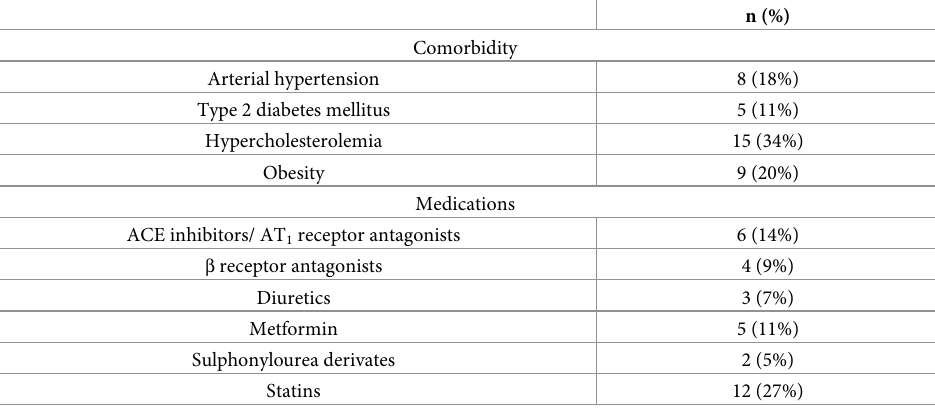
Table 1. Comorbidities and medications in the study